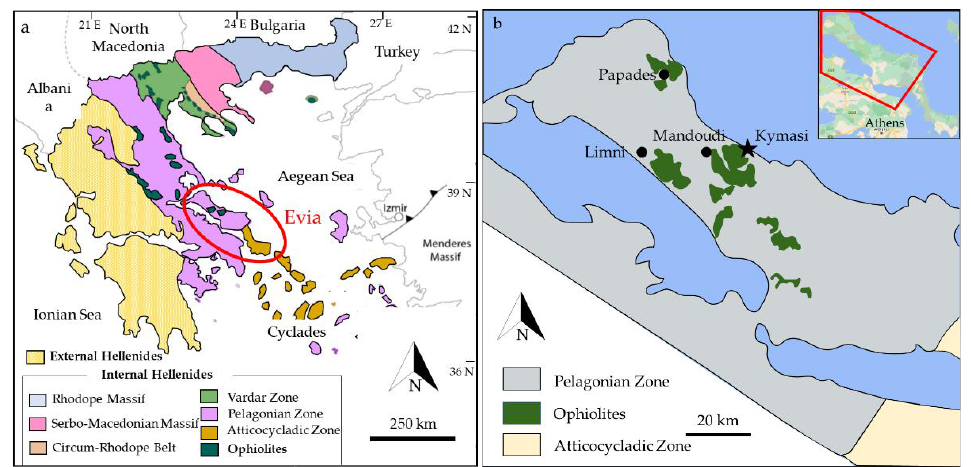
Figure 1. ( a ) Simplified map showing the major structural elements of Greece. Modified after [21,22]; ( b ) Simplified map of Norther Evia showing the major ophiolite bodies of the area. Kymasi miner- alization are indicated by the black star. Modified after [23].